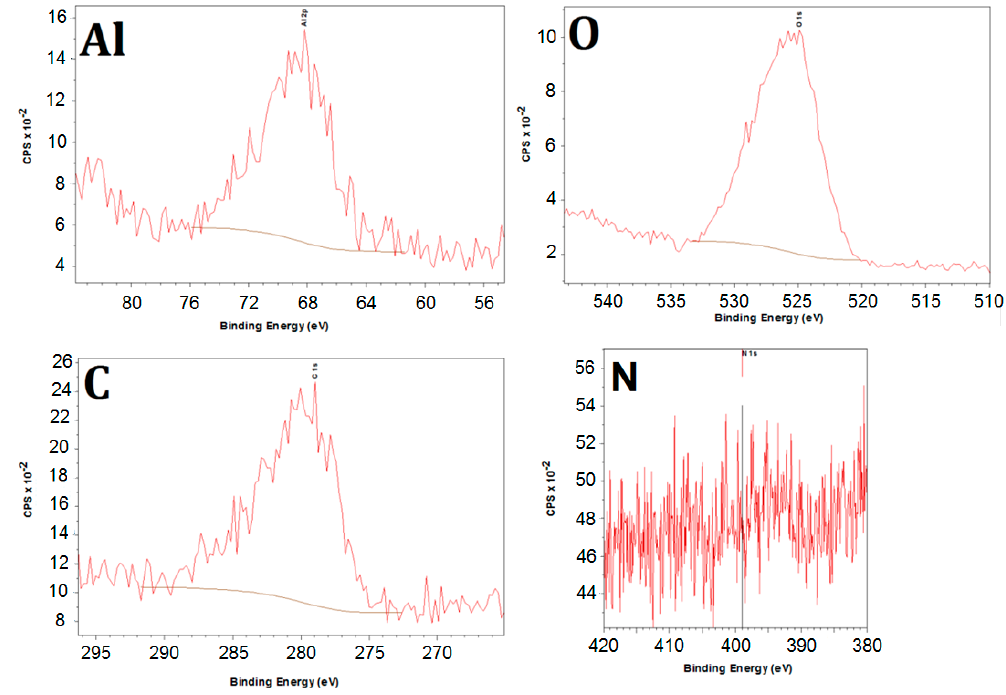
Figure 12. XPS integrated spectra for C, O, N and Al for the CoatAlloy ™ sample after the typical pretreatment for Fe-Ni-Cr alloys.